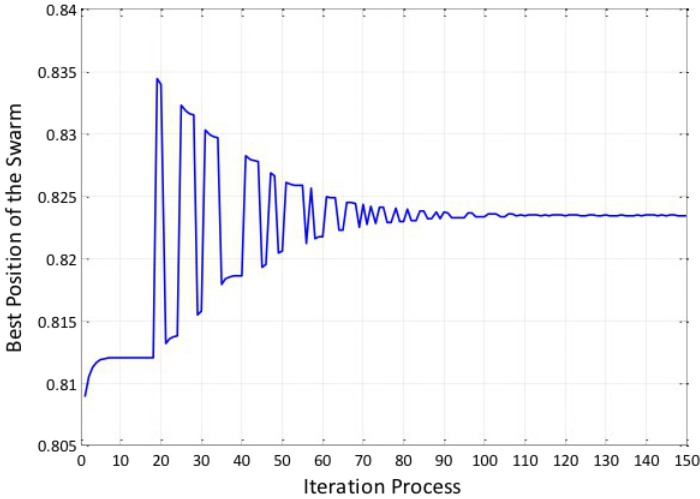
Figure 4. Global best position of the swarm in every iteration